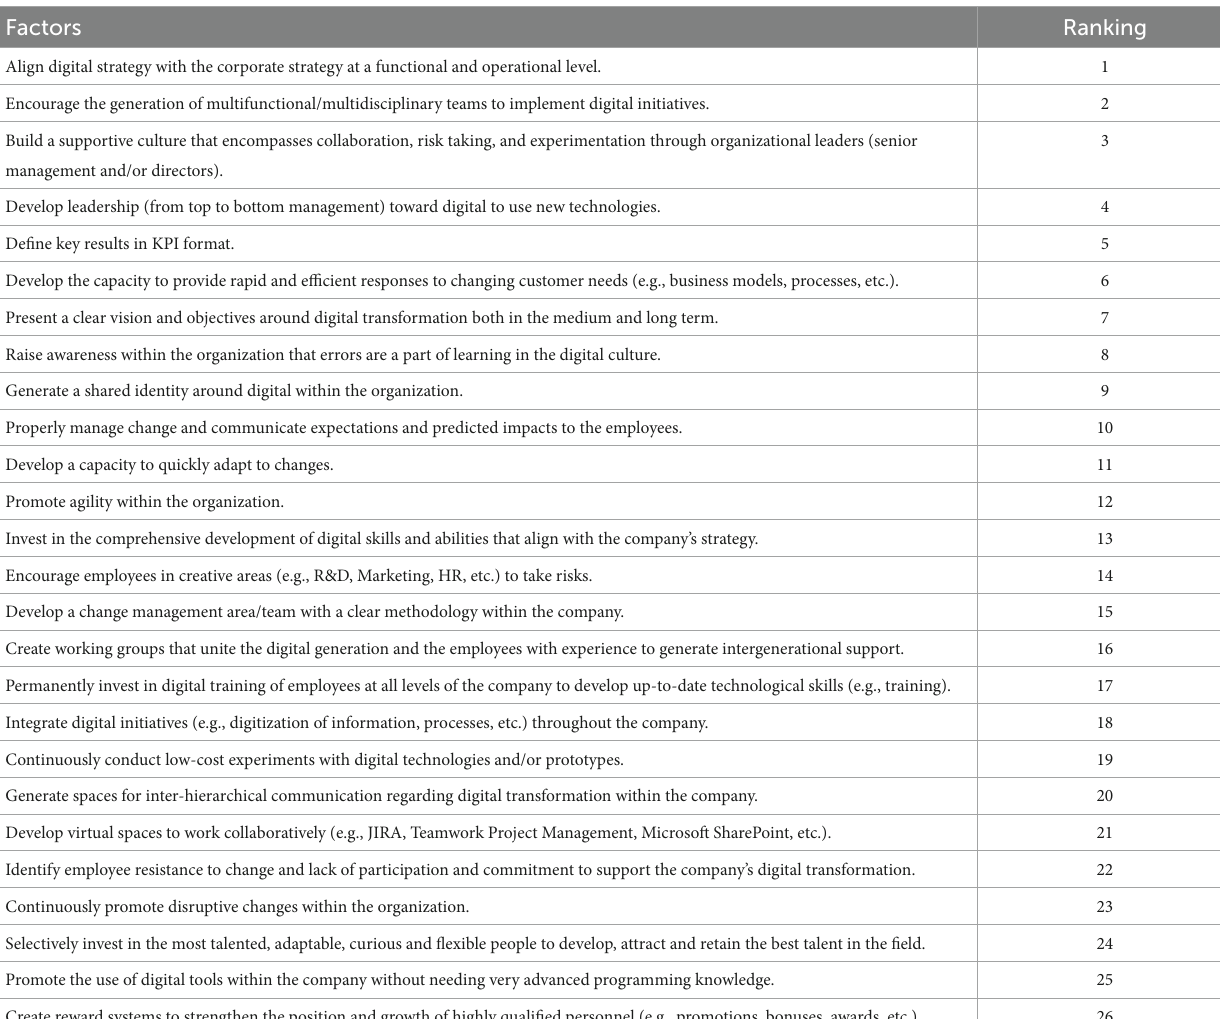
TABLE 7 Ranking of factors that promote a digital culture in large companies in Chile.